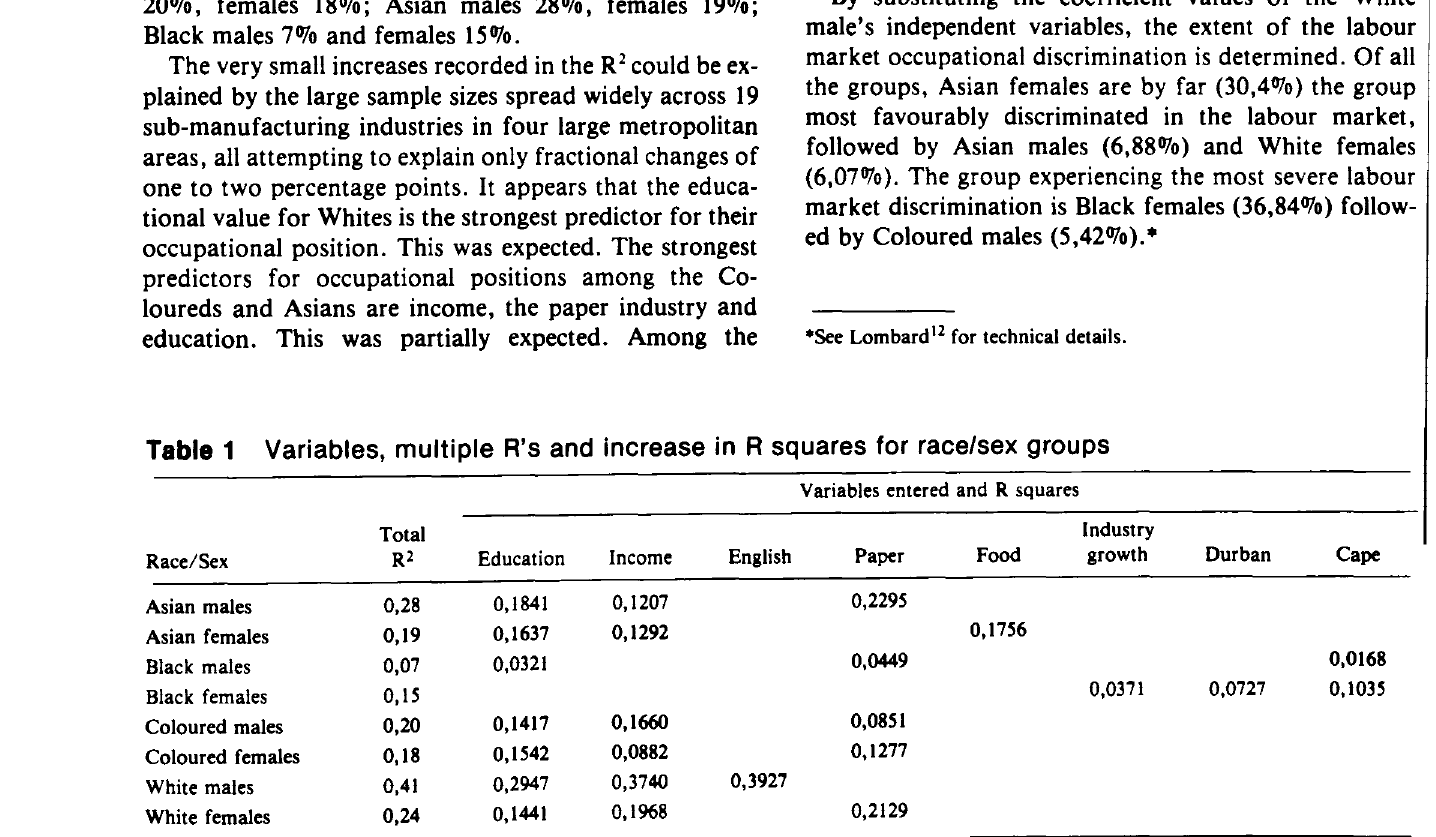
Table 1 Variables, multiple R's and increase in R squares for race/sex groups